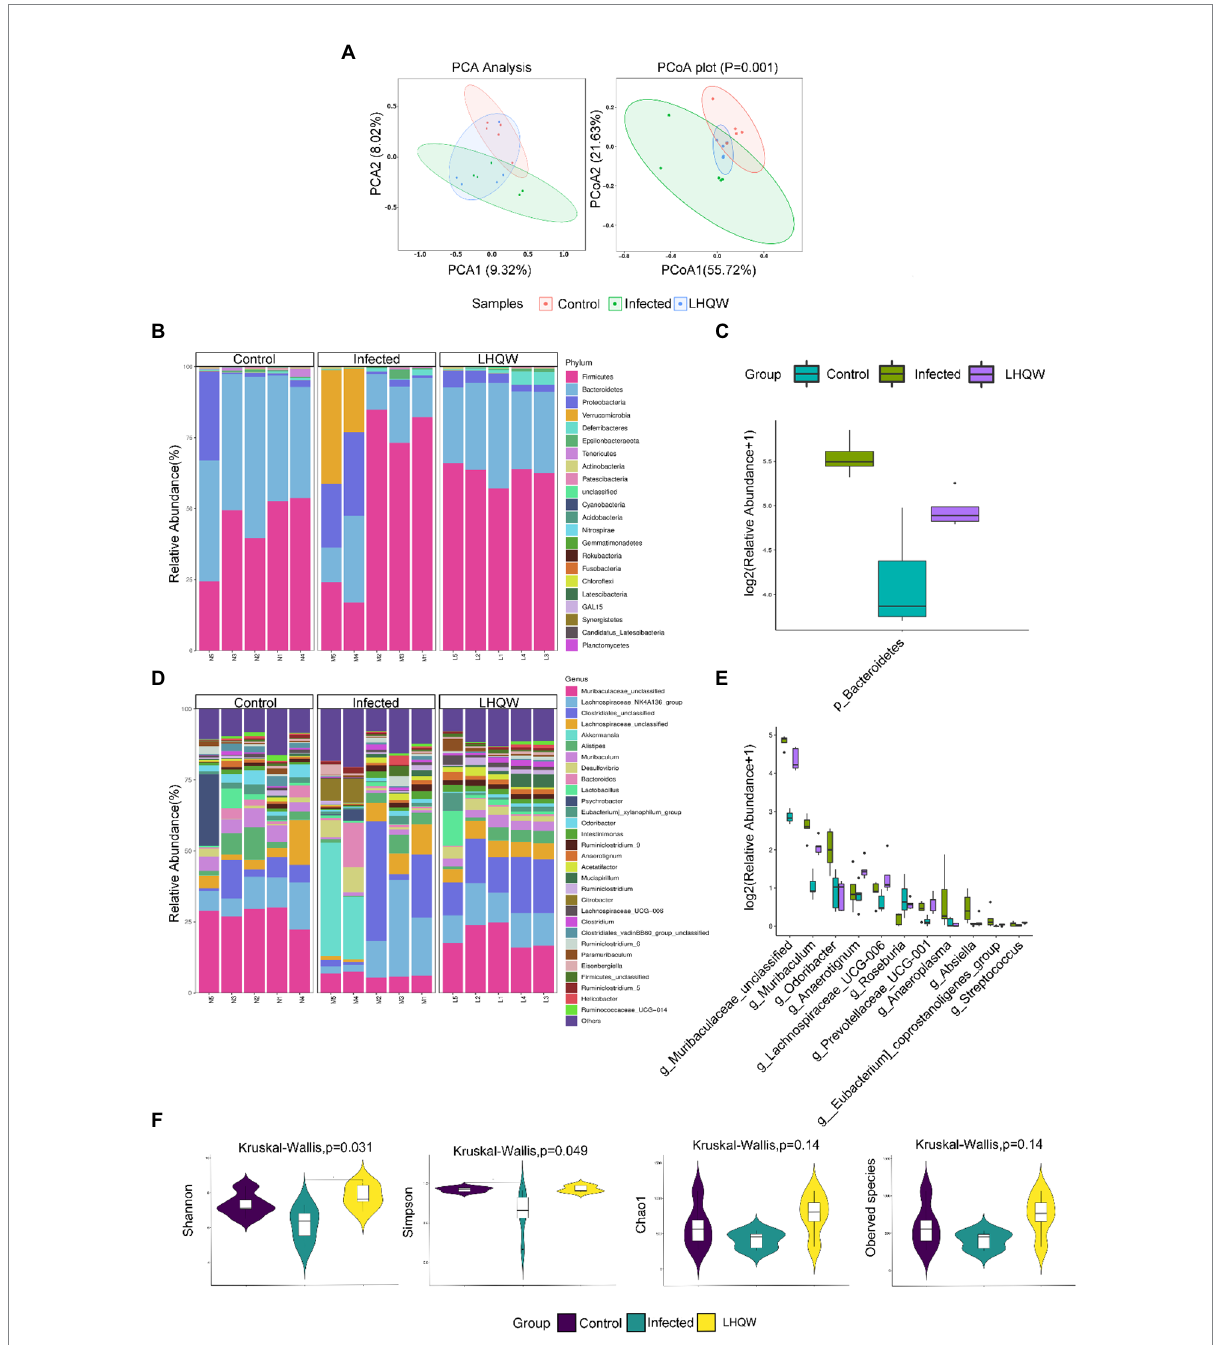
FIGURE 2 LHQW significantly improves the imbalance of intestinal flora induced by H1N1. (A) Beta diversity observed using principal component analysis (PCA) and principal coordinates analysis (PCoA). The same group is circled according to the 95% confidencce interval. The closer the distance between the two samples, the more similar the microbial composition structure between the samples and the smaller the difference. The sp©re analyzed at the phylum and genus levels, and those with significant differences were used to draw a box diagram. Using the genus level as an example, the abscissa represents the species with significant difference with a value of p less than 0.05 in the difference analysis, arranged from left to right according to the abundance from high to low. The ordinate represents the relative abundance. The figure shows the relative abundance of each species in each group. The taxonomic distribution of intestinal bacterial composition at the phylum level, including column stacking diagram (B) and box line diagram (C) ; The taxonomic distribution of intestinal bacterial composition at the genus level, including column stacking diagram (D) an©ox line diagram (E) . (F) Alpha diversity indexes, including Chao1, observed species, Shannon, and Simpson indexes. Chao1 and ACE indexes are mainly used to evaluate flora richness. The larger the value, the higher the flora richnes’. Shannon and Simpson’s indexes are mainly used to evaluate flora diversity. Higher Shannon index and lower Simpson index indicate higher species diversity of the